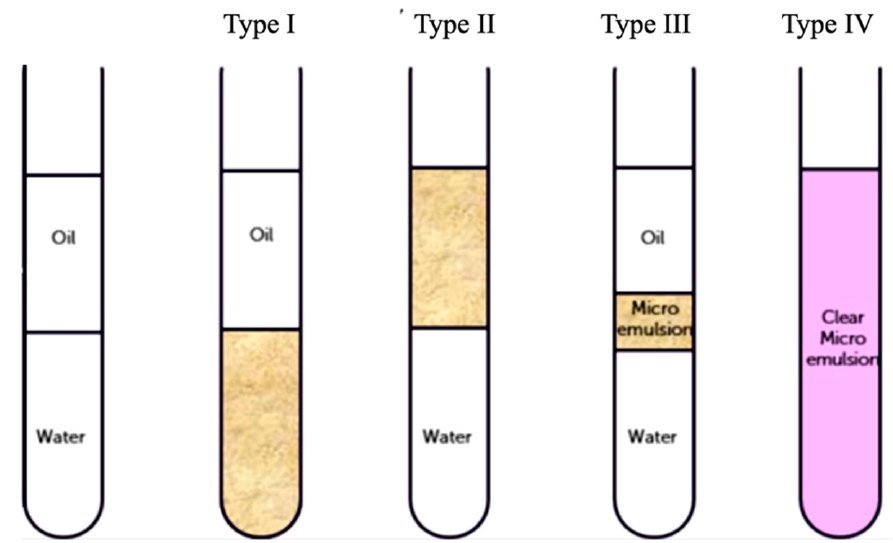
Figure 3. Different types of emulsions proposed by Winsor.